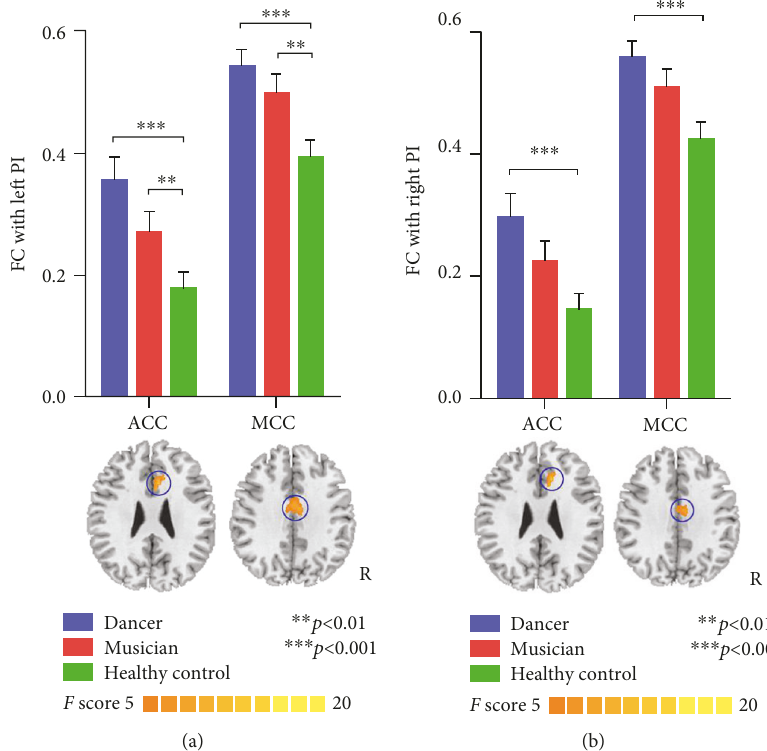
Figure 1: Functional connectivity of PI seeds. (a) Represents the results of the left PI, and (b) represents the results of the right PI. There is increased FC between PI and ACC and MCC in dancers and musicians compared with